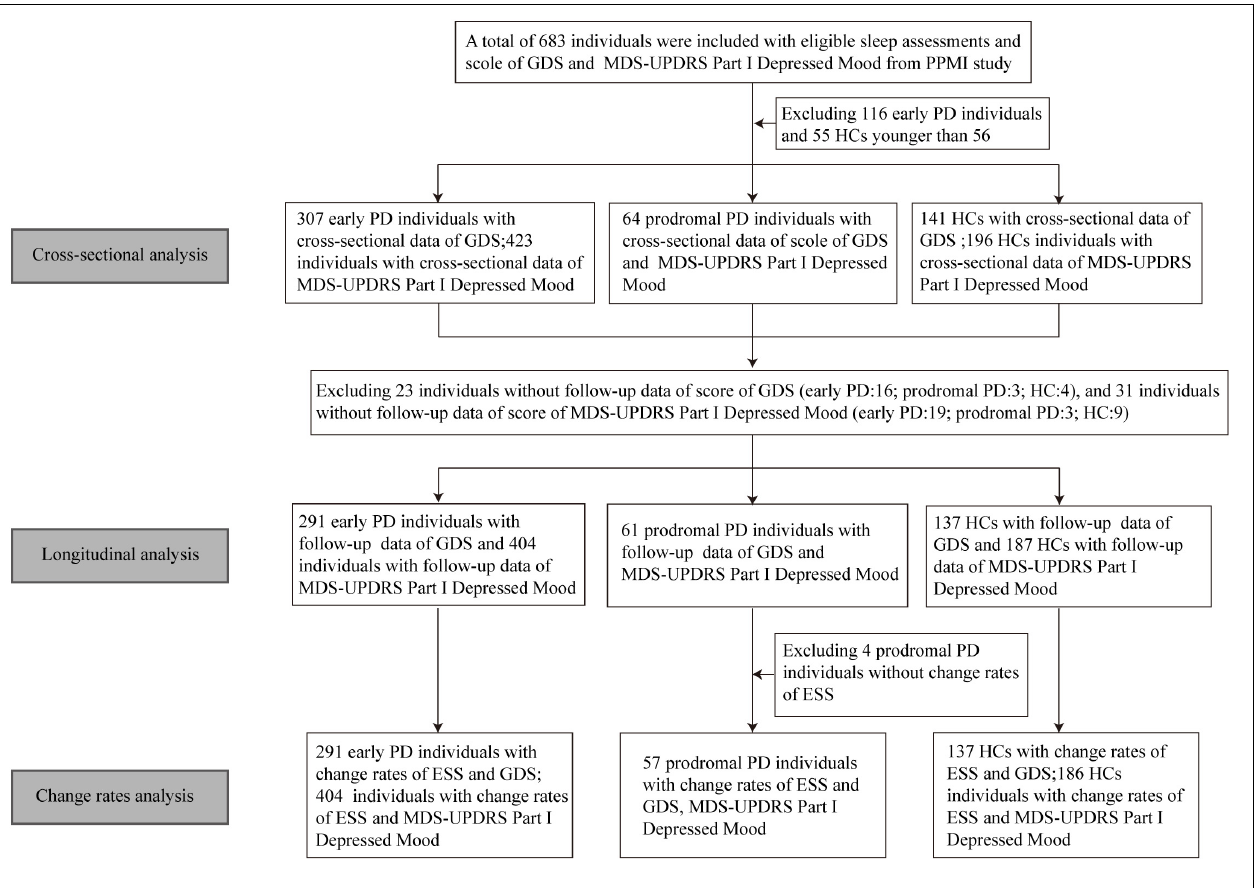
FIGURE 1 | Flowchart of data analysis. GDS, geriatric depression scale; MDS-UPDRS, movement disorder society-sponsored revision unified Parkinson’s disease rating scale; PPMI, Parkinson’s progression markers initiative; PD, Parkinson’s disease; HC, healthy control; ESS, Epworth sleep